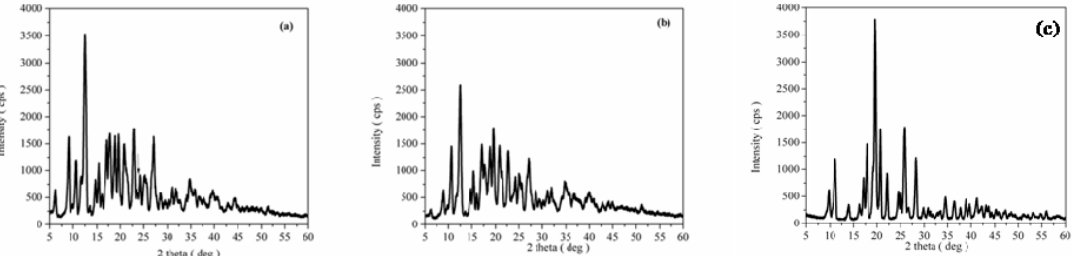
ff raction (XRD) pattern of ( a ) β -CD, ( b ) processed β -CD and ( c ) CAP. Pharmaceutics 2020 , 12 , x FOR PEER REVIEW